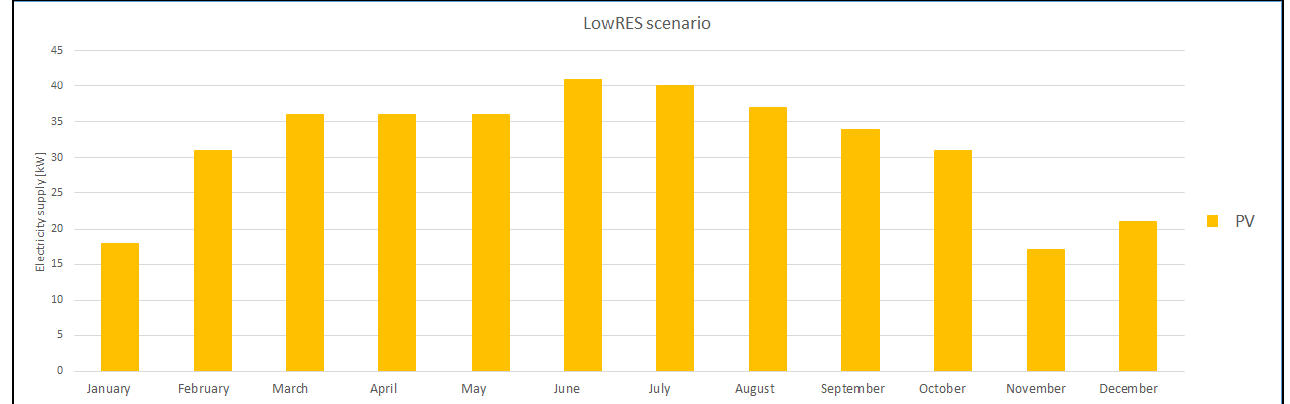
Figure 7. Average PV systems’ output power values for Scenario 1.